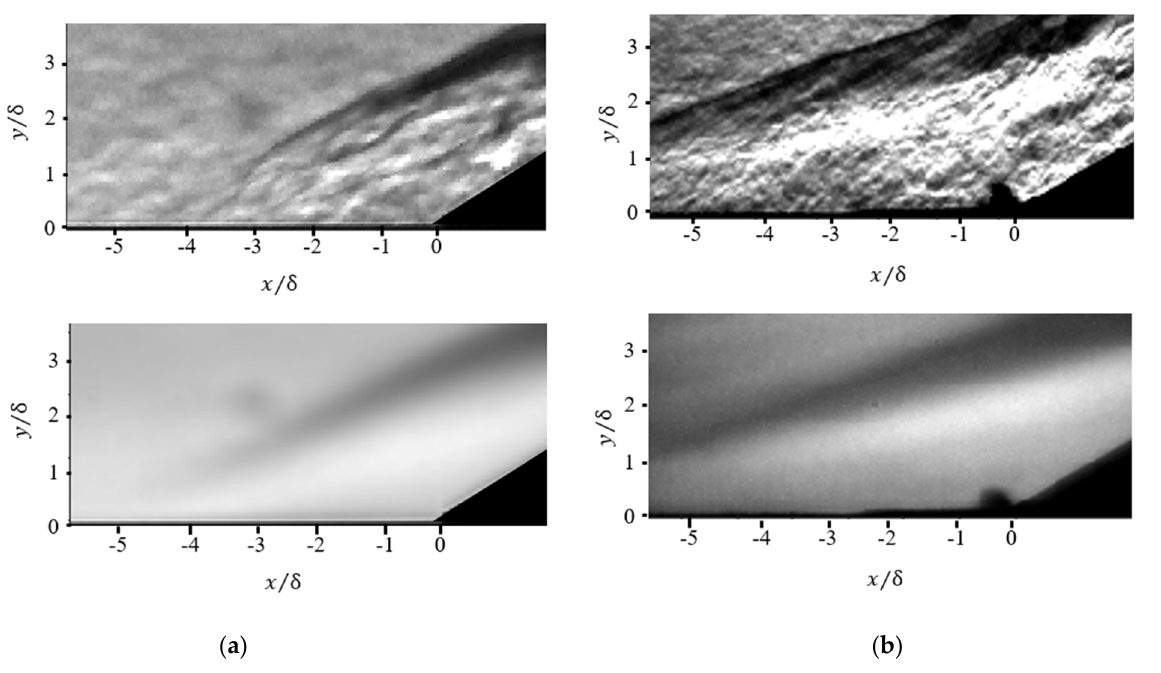
Figure 4. Instantaneous (top) and mean (bottom) schlieren visualizations of SWBLI, ( a ) smooth surface, and ( b ) rough surface.